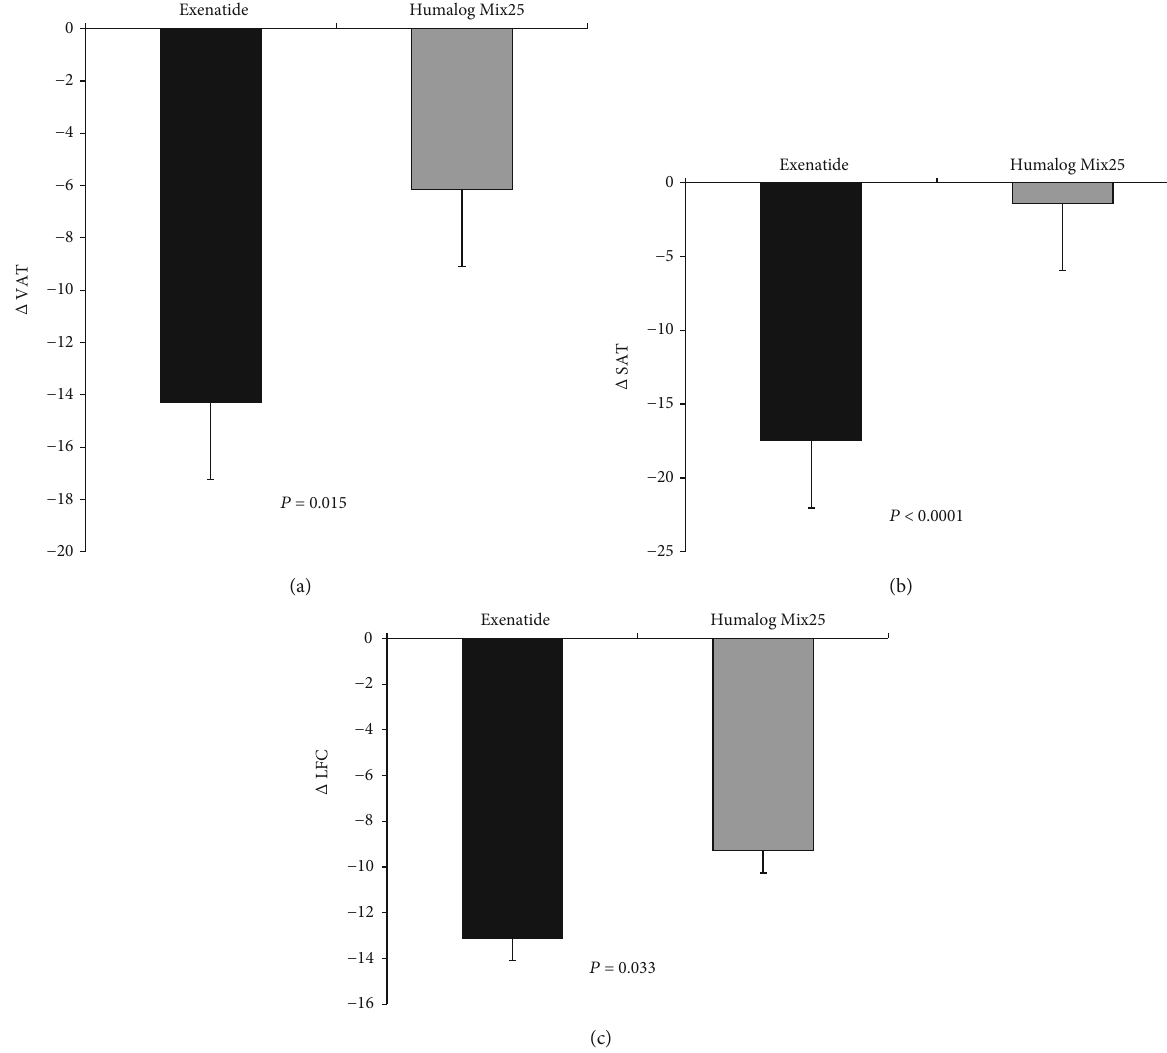
Figure 3: E ff ects of exenatide or humalog Mix25 on fat distribution and liver fat content (LFC). Changes in visceral adipose tissue (VAT) (a), subcutaneous adipose tissue (SAT) (b), and LFC (c) after exenatide or humalog Mix25 intervention in normal BMI patients with T2DM and visceral adiposity. P values represent comparisons of changes between the two intervention